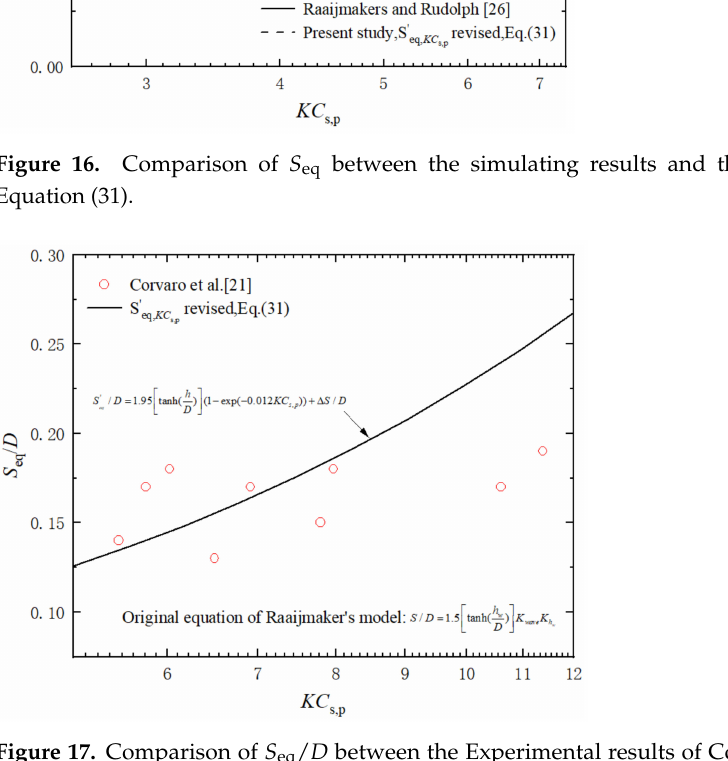
Figure 17. Comparison of S eq / D between the Experimental results of Corvaro et al. [21] and the predicting values by Equation